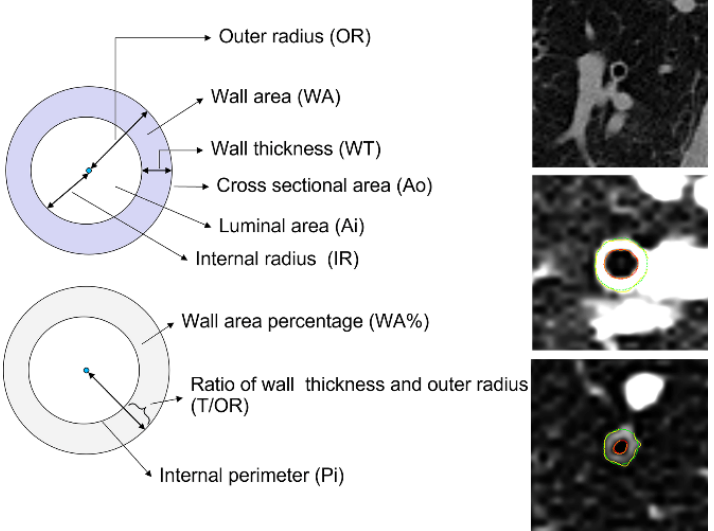
Figure 1. Indices of airway wall thickness ( left part ) and representative HRCT scans ( right part ).